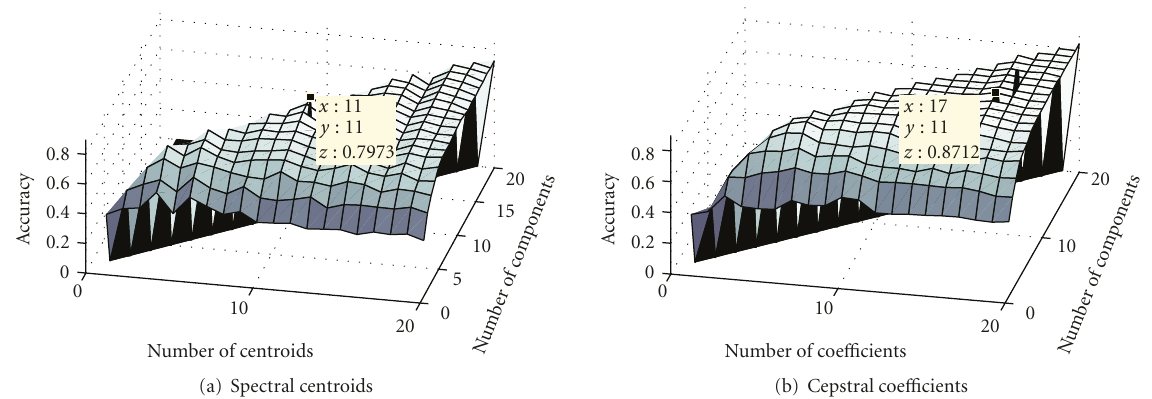
Figure 4: On adjusting the number of TFR-based dynamic features.